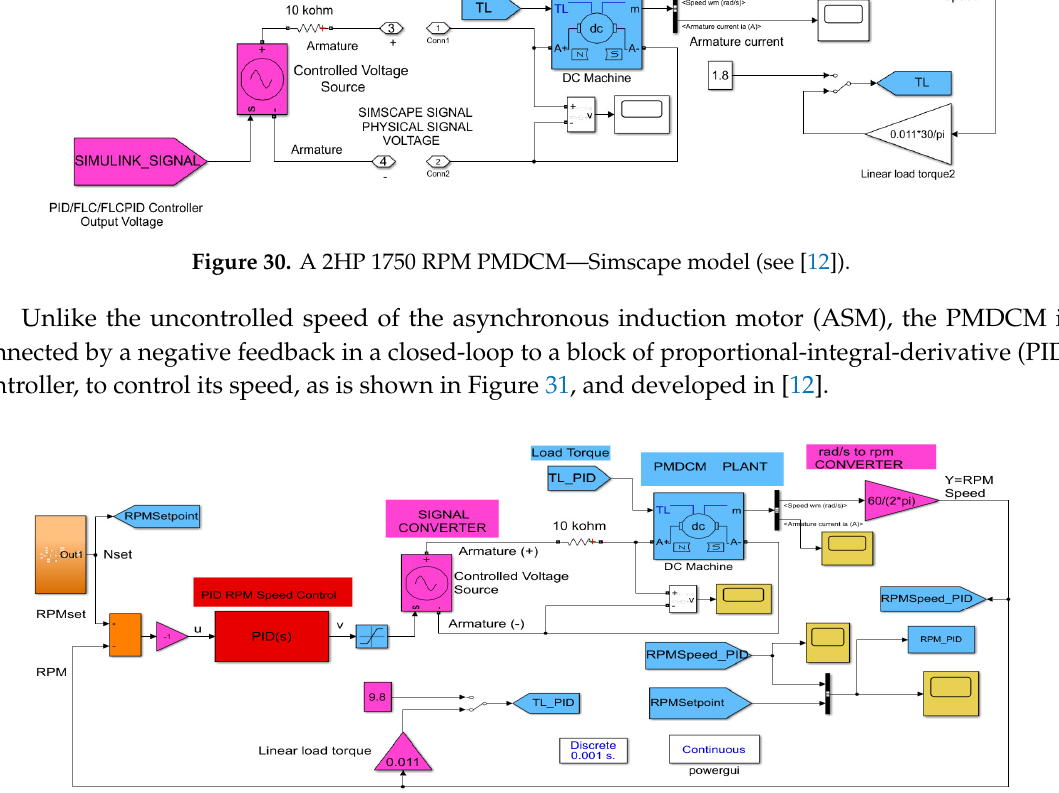
Figure 32. PMDCM RPM speed step response. The characteristics curves of a Li-ion battery connected to PMDCM as a DC load are shown in Figure 33a–c, namely the battery SOC (a), a sequence of discharging and charging current cycles (b), and the battery terminal output voltage changes during battery operation (c). The SOC of the Li-ion battery remains almost constant during PMDCM operation. The battery current increases to almost 15 A at the beginning of the first transient and remains constant for a short period of time during steady state. However, at the beginning of the second transient it rises sharply to 60 A for a short